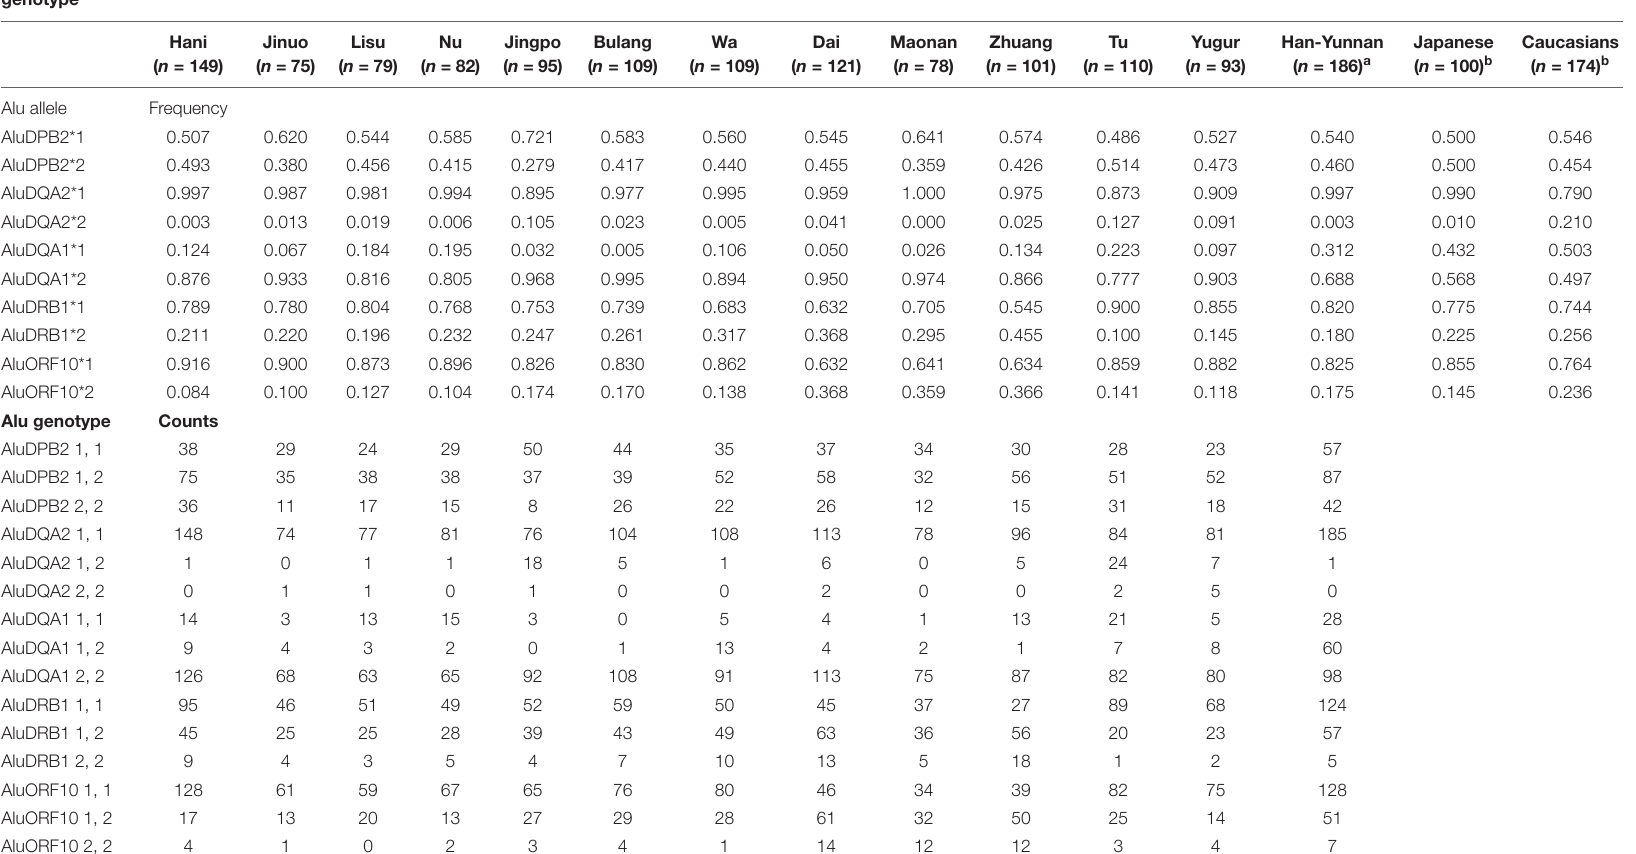
TABLE 3 | The MHC POALIN allelic frequencies and genotype counts at five loci in 15 populations. Alu allele or